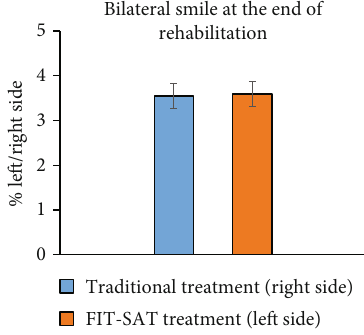
Figure 7: The graph shows the results between the % right side and the % left side (the Euclidian distances in millimeters between the left/right lip corner marker and the nose marker, Figure 3(b)) at the fi rst acquisition (T1, blue) and at the last acquisition (T2, orange), respectively. Error bars represent SE (standard errors of the